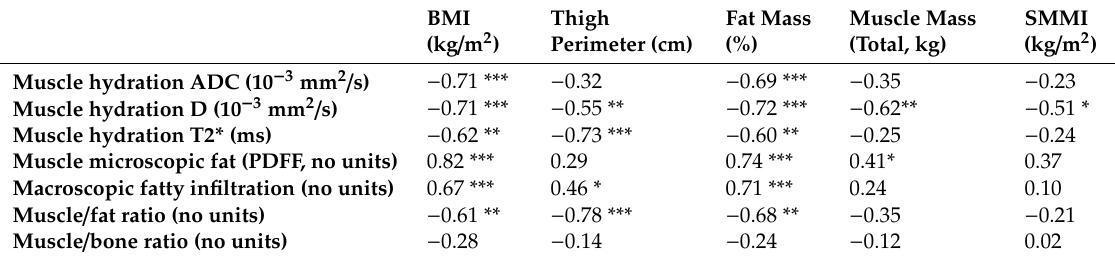
Table 3. Statistically significant correlations between imaging biomarkers and cineanthropometric parameters with | r | > 0.4.